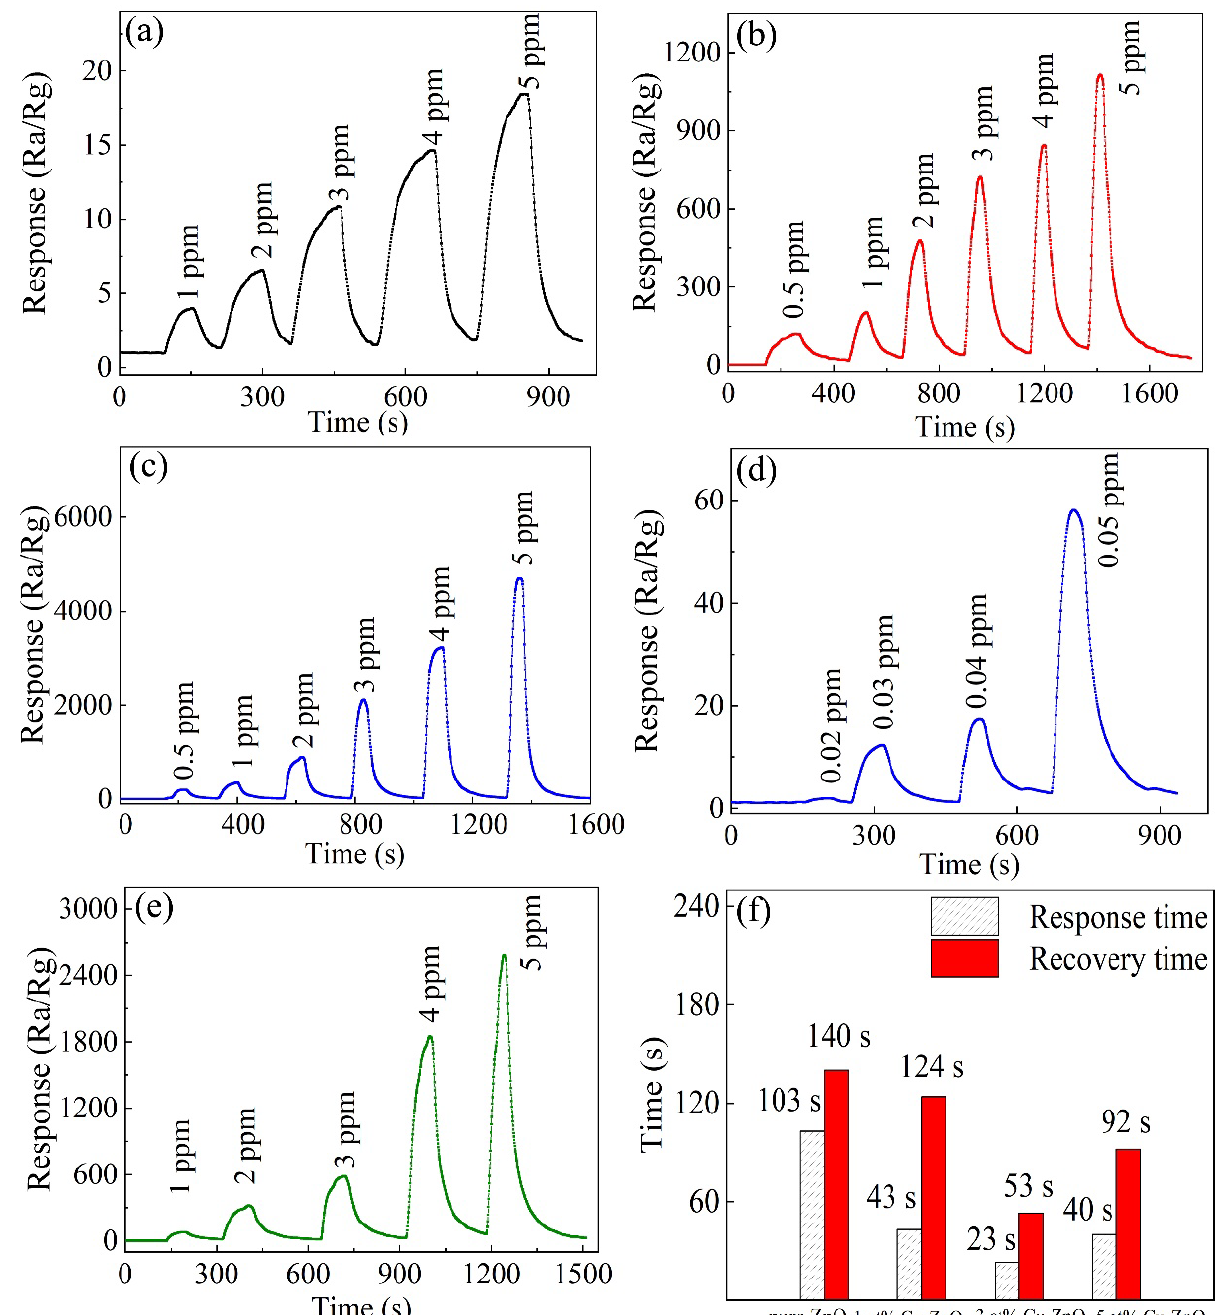
Figure 6. Dynamic-response curves of the sensors based on ( a ) pure ZnO nanocages, ( b ) 1 at% Cu-doped ZnO nanocages, ( c , d ) 3 at% Cu-doped ZnO nanocages, and ( e ) 5 at% Cu-doped ZnO nanocages for different concentrations of H 2 S at their optimal operating temperatures. ( f ) Response and recovery times of all samples.